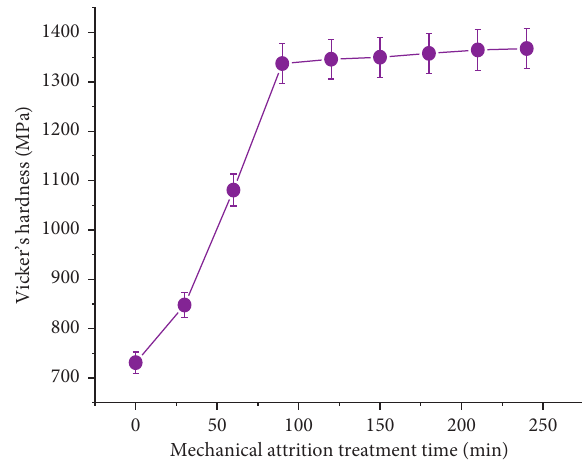
Figure 4: Hardness variation with time of attrition